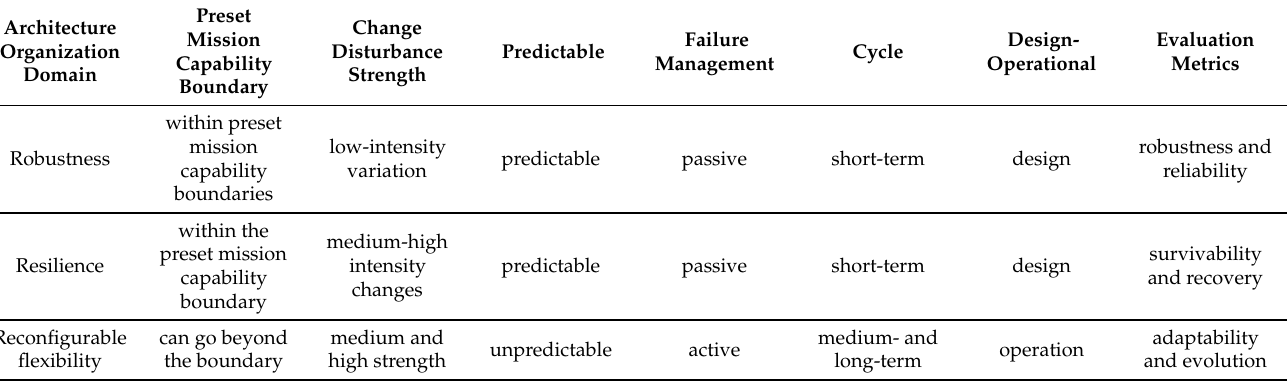
Table 2. Domain partitioning of architecture design for architecture